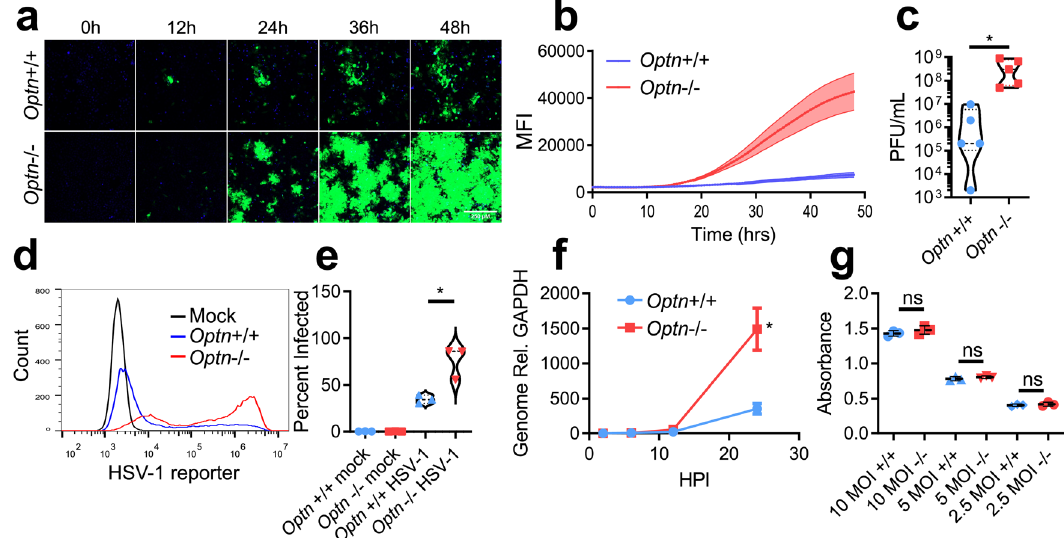
Fig. 1 OPTN restricts spread of HSV-1. a Representative time-lapse imaging of Optn + / + and − / − cells infected with GFP-HSV-1 17-strain at 0.1 MOI for 48 h. Time interval was 30 min. Scale bar is 250 µ m. b Quanti fi cation of average time-lapse fl uorescent intensity over time for three replicates. c Violin plot of Optn + / + and − / − cells infected with HSV-1 at 0.1 MOI and assayed for plaques 24 hpi. n = 5 independent replicates per group. P = 0.0446. d , e (left) Histogram of Optn + / + and − / − cells infected with GFP- HSV-1 at 0.1 MOI 24 hpi measured by fl ow cytometry, (right) violin plot of percentage of cells infected with GFP-HSV-1. n = 3 independent replicates per group. P = 0.0174. f Genomes present in Optn + / + and − / − cells infected with GFP- HSV-1 at 0.1 MOI. n = 3 independent replicates per group. P = 0.0220. g Colorimetric readout of replication de fi cient and β -galactosidase expressing HSV-1 infected Optn + / + and − / − cells at multiple MOIs. n = 3 independent replicates per group. P = 0.3083 (10 MOI), P = 0.3575 (5 MOI), P = 0.4945 (2.5 MOI). Data are presented as mean values ± SEM ( b , f ). Two-tailed Student ’ s t test was performed for statistical analysis ( α = 0.05). ∗ p < 0.05; ns not signi fi cant. Source data are provided as a Source Data fi